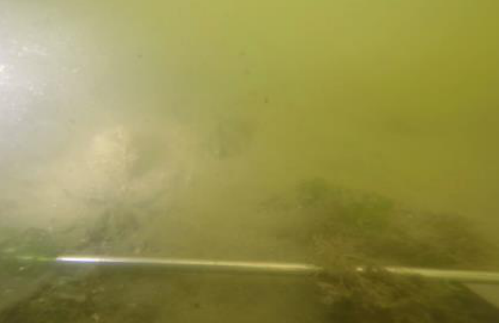
Figure 3. Sample image recorded by GoPro Hero 4.